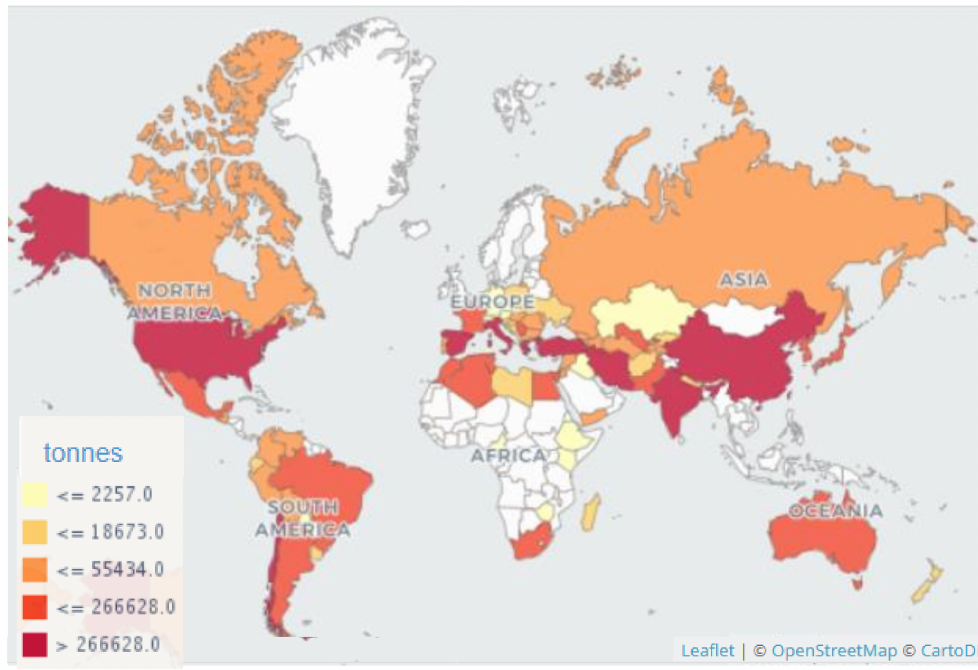
Figure 1. Global map of peach and nectarine production. Source: http://www.fao.org/faostat/en/ #data/QC/visualize